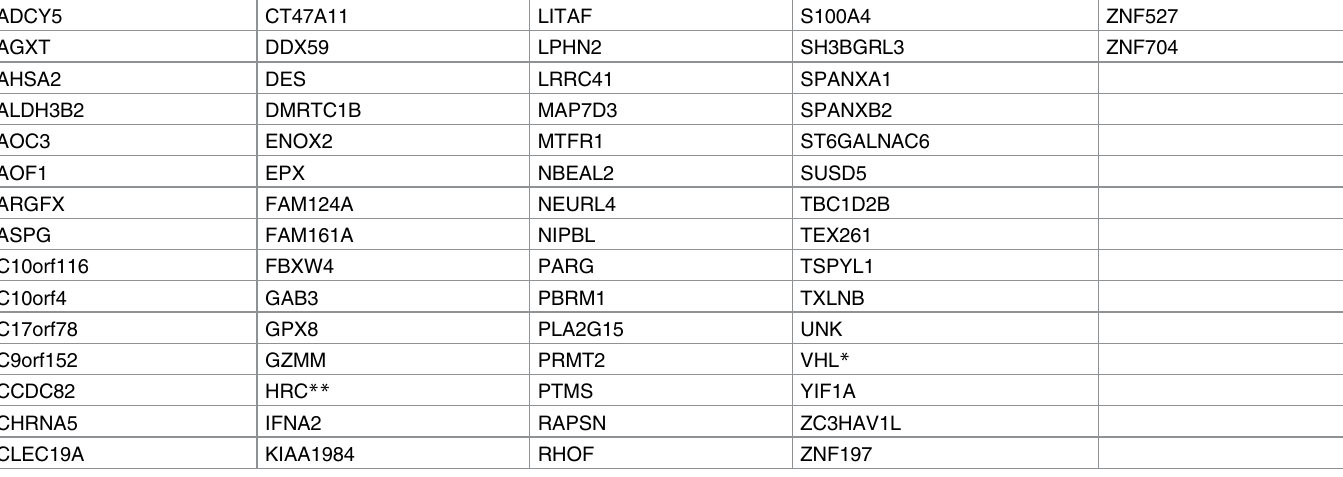
Table 3. Brain vascularsmooth muscle proteins curated from the Human Protein Atlas. Proteins (n = 62) predicted to be expressedonly in vascular smooth muscle of the brain but not in EC of the brain are listed. All proteins stains localizedto vascular cells but not substantially or consistently in other cells of the central nervous system. Unlessindicated,all proteinswere found in both non-brainVSMC and non-vascular SMC.